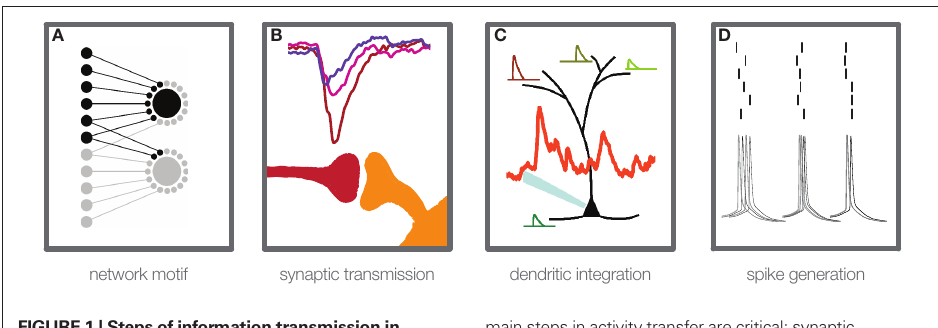
Figure 1 | Steps of information transmission in neuronal networks. Convergent feed-forward connected neurons (A) are a basic motif for many theories of cortical information processing. A certain degree of convergence is necessary, due to the fact that postsynaptic potentials from single cortical connections are usually too weak to elicit an action potential in the postsynaptic cell. For theories that build on temporally precise signal integration and action potential generation in single neurons, three